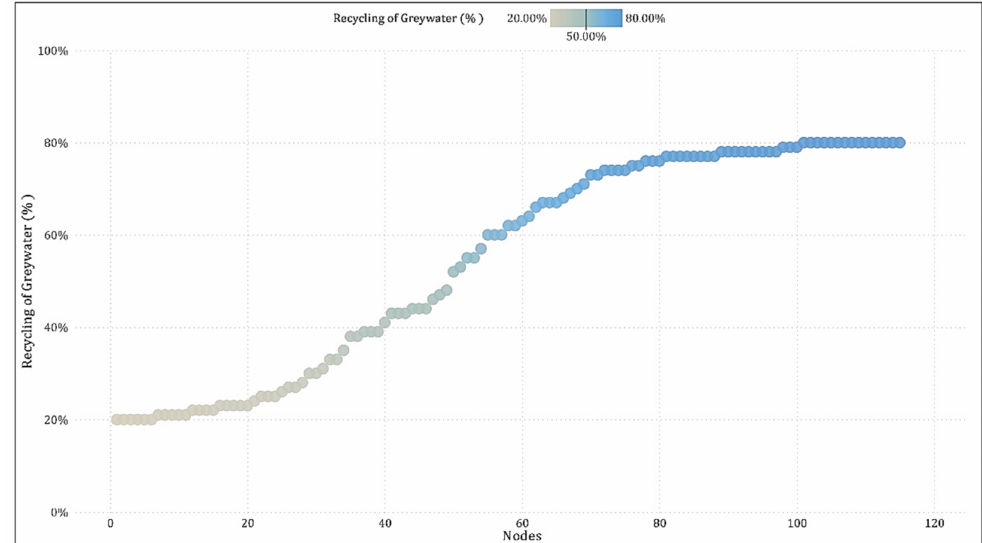
Figure 7. Optimal fractions of graywater treatment at each node: IIT Madras network (node number identification is given in Table S3 in the Supplementary